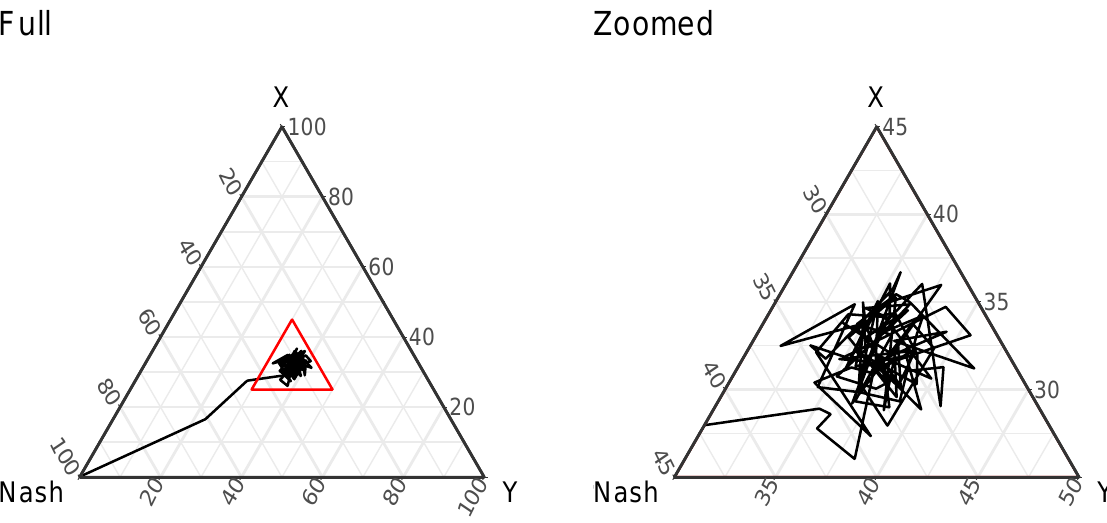
Figure 7 – Ternary plot of the first 2500 generations of the simulation in Fig. 6. X and Y are the two non-Nash strategies. The right panel zooms in on the region of the red triangle in the left panel. Every 50th generation is